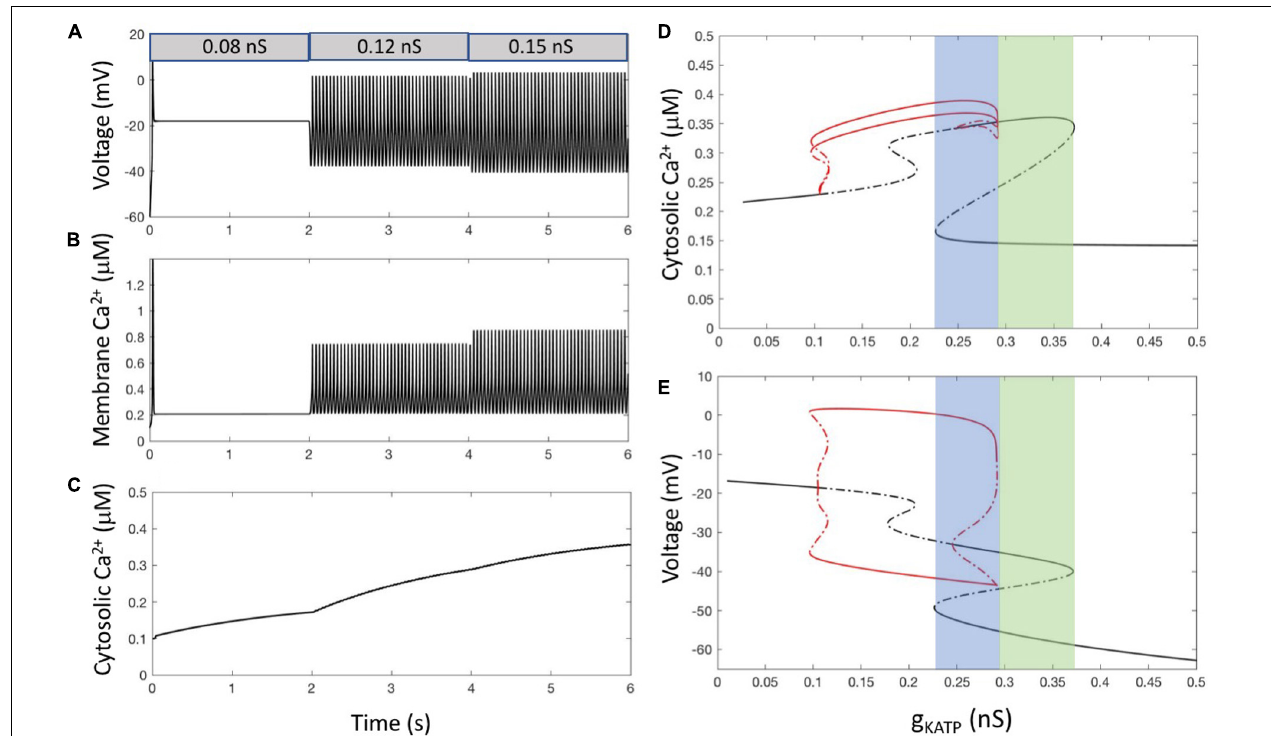
FIGURE 2 | α -cell Ca 2 + dynamics resulting from electrical activity. (A) Membrane voltage for 3 values of g KATP , simulating a decrease in external glucose. From t = 0 to 2 s, g KATP = 0.08 nS and g leak = 0.2 nS. From t = 2 to 4 s, g KATP = 0.12 nS and g leak = 0.2 nS. For t > 4 s, g KATP = 0.15 nS and g leak = 0.13 nS. The decrease in g leak that accompanies the increase in g KATP allows the model to reproduce the experimentally observed lower maximum voltage reached during repetitive AP’s at high glucose (Montefusco and Pedersen, 2015). (B) Corresponding changes in [Ca 2 + ] in the sub-plasmalemmal compartment ( Ca m ). (C) Corresponding changes in [Ca 2 + ] in the cytosol ( Ca c ). Because diffusion is much slower than electrical activity, cytosolic concentration does not follow the Ca 2 + spikes occurring just below the membrane. (D,E) Bifurcation diagrams showing the evolution of Ca c (D) and voltage (E) when changing g KATP . In both panels, black lines indicate steady states, while red lines show the minimum and maximum values reached during limit cycle oscillations. Plain lines indicate stable solutions and dashed lines instable ones. Bifurcation diagrams have been established using the AUTO package of xppaut (Ermentrout, 2002). For all panels, equations are those corresponding to Model 1 (see section “Outline of the Modeling Approach”) with the default values of parameters listed in Supplementary Tables 1, 2 of the Supplementary Material , except for the indicated values of g KATP and g leak . In panels (D,E) , g leak = 0.2